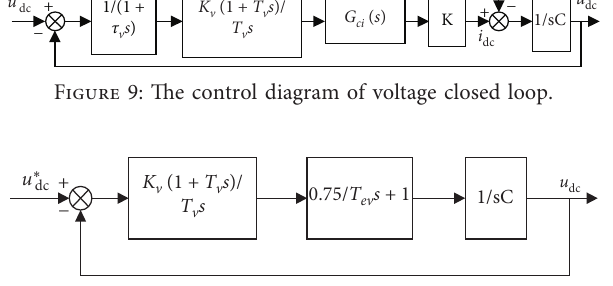
Figure 10: The simplified control diagram of voltage closed